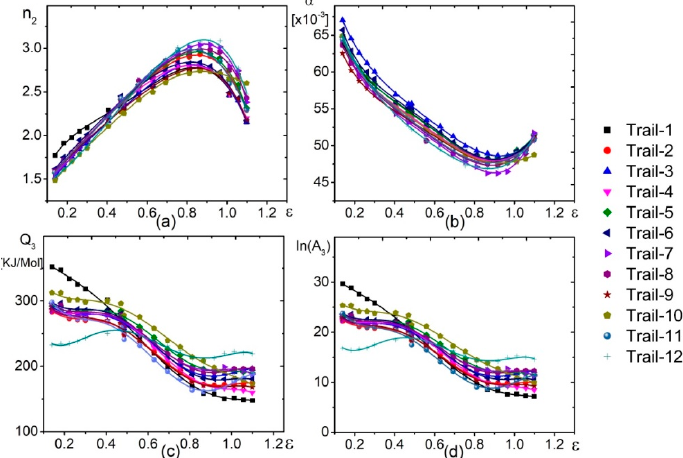
Figure 8. Variation of n 2 , α , Q 3 and ln( A 3 ) with true strain for all trails: n 2 ( a ); α ( b ); Q 3 ( c ); and ln( A 3 ) ( d ) using Arrhenius-type constitutive equation (ACE) model.